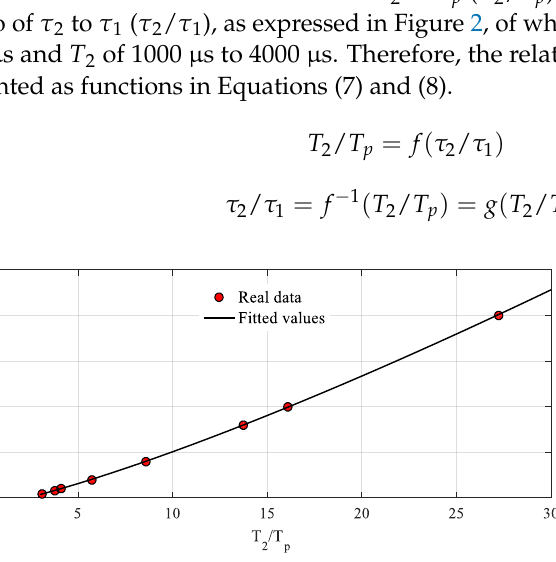
Figure 2. τ 2 / τ 1 as the function of T 2 / T p and the fitting curve.